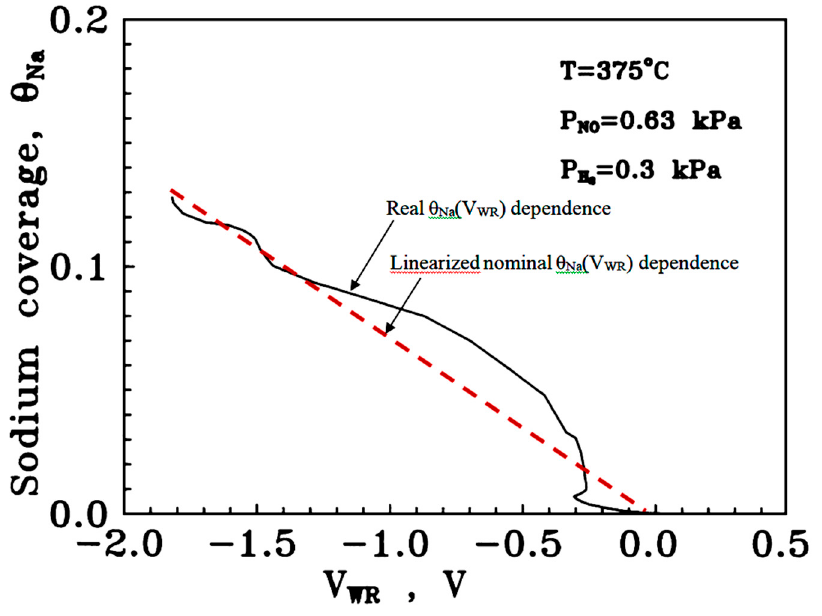
Figure 3. Dependence of alkali coverage on catalyst potential V WR under certain reaction conditions (Reproduced with permission from Ref. [19]. Copyright 1997, (Reproduced with permission from Ref. [19]. Copyright 1997, Elsevier).